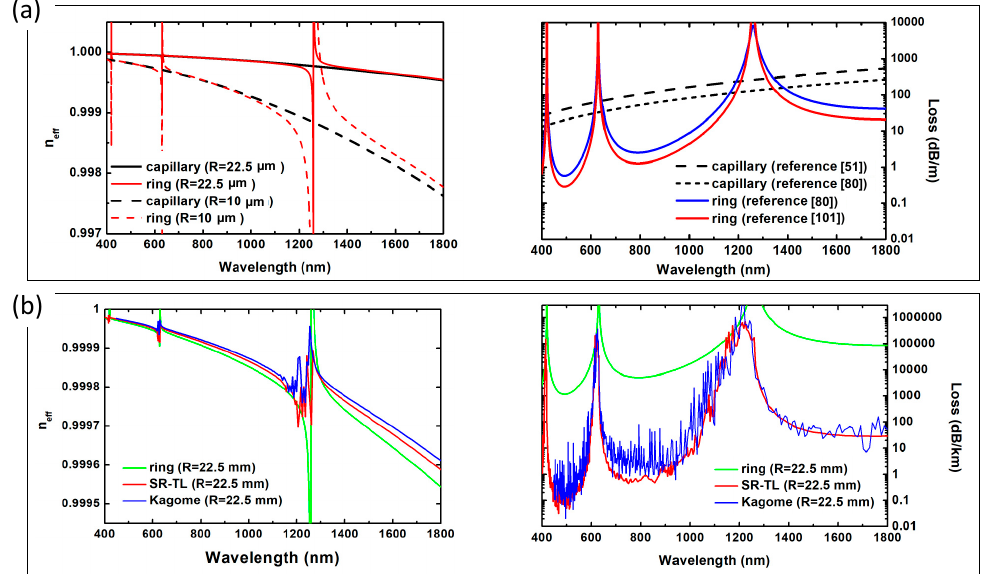
Figure 21. ( a ) lhs : Effective index spectrum glass capillary (black curves) and 600 nm thick ring (red curves) for the case of a radius of 22.5 µm (solid lines) and 10 µm (solid lines). rhs : Loss spectrum of 22.5 µm radius glass capillary calculated using the expression of Reference [50] (black dashed-dotted curve). Loss spectrum of 22.5 µm radius and 600 nm thick glass ring using the expression from Reference [76]. ( b ) Effective index ( lhs ) and loss spectra ( rhs ) of ring, SR-TL, and Kagome fiber with similar core diameter of 22.5 µm and struts thickness of 600 nm.